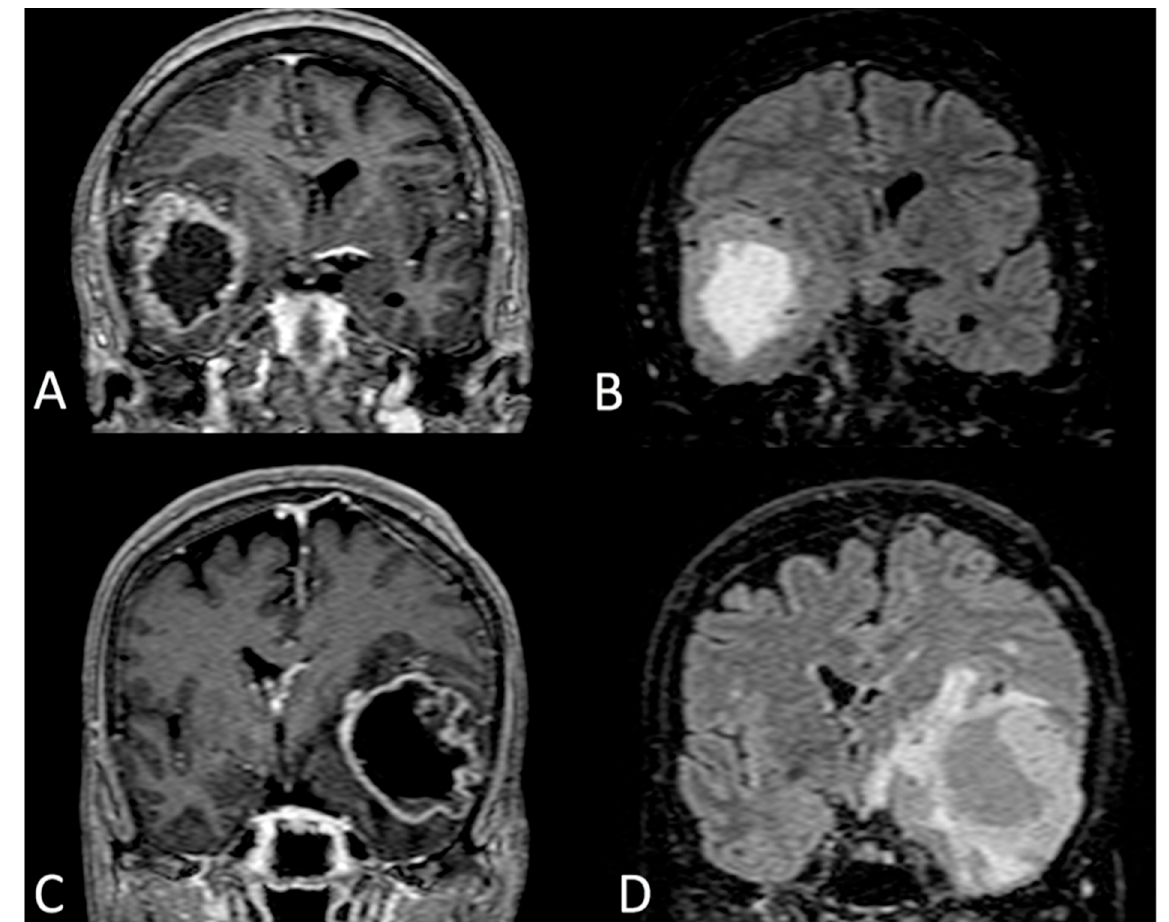
Figure 5. Coronal section of MRI T1 with gadolinium ( A ) and FLAIR sequences ( B ) of a proliferation-dominant type of temporal GBM (bulky tumor with compressive effect and a low rate of peritumoral infiltrative areas). Coronal section of MRI T1 with gadolinium ( C ) and FLAIR sequences ( D ) diffusion-dominant type of a temporal GBM (bulky tumor with extensive infiltration of white matter in peritumoral areas).